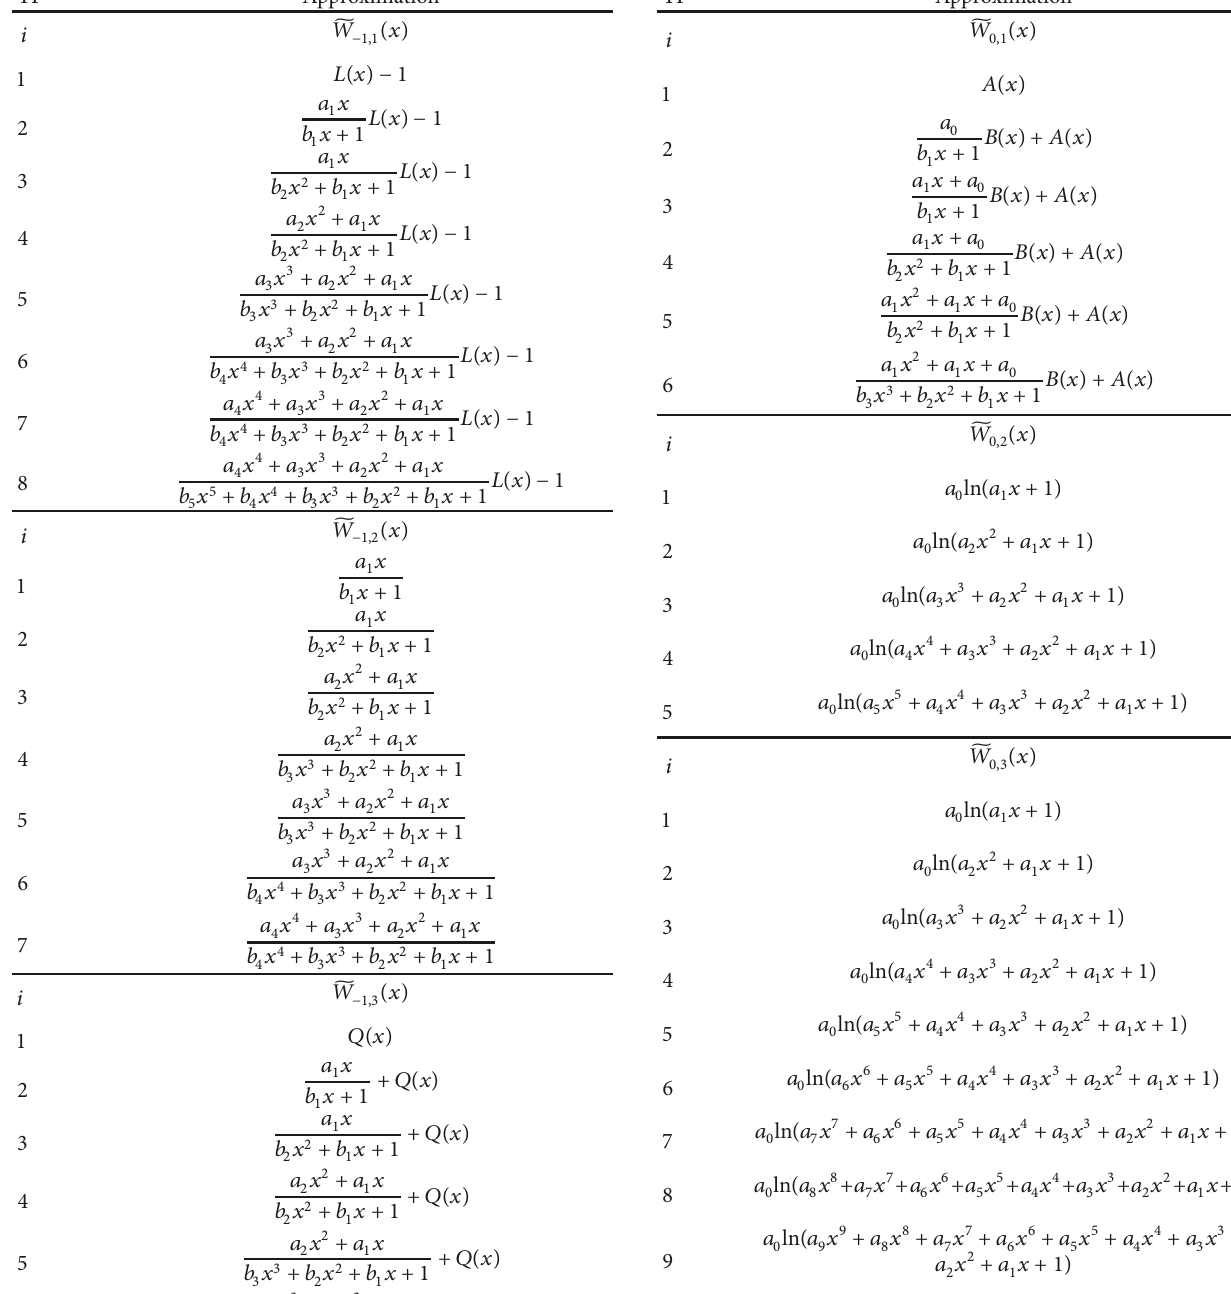
Table 1: Trial ( 𝑖 -th) functions (TF) for PSEM for ̃𝑊 (𝑥) . and −1,3 TF